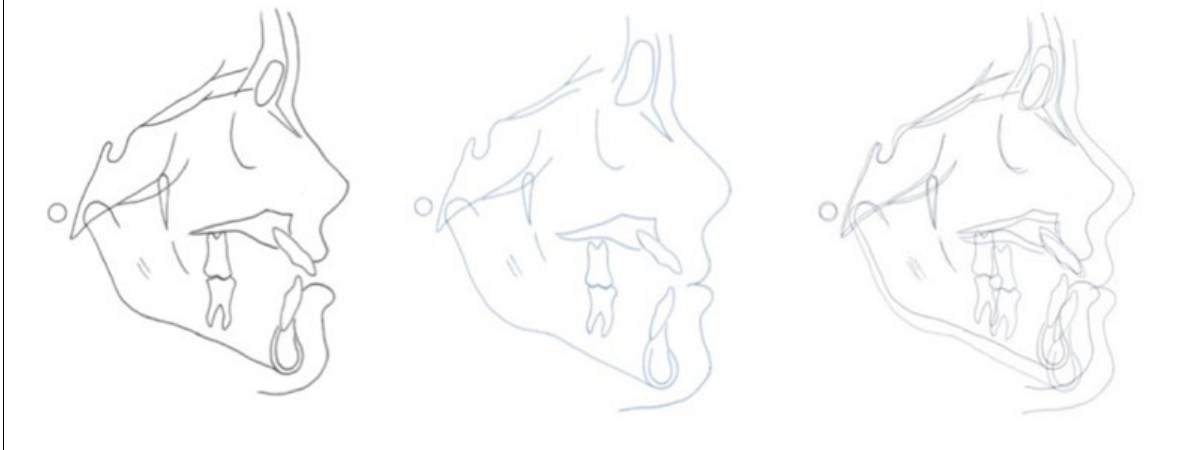
Figure 2b. Cephalometric superimpositions (2008 and